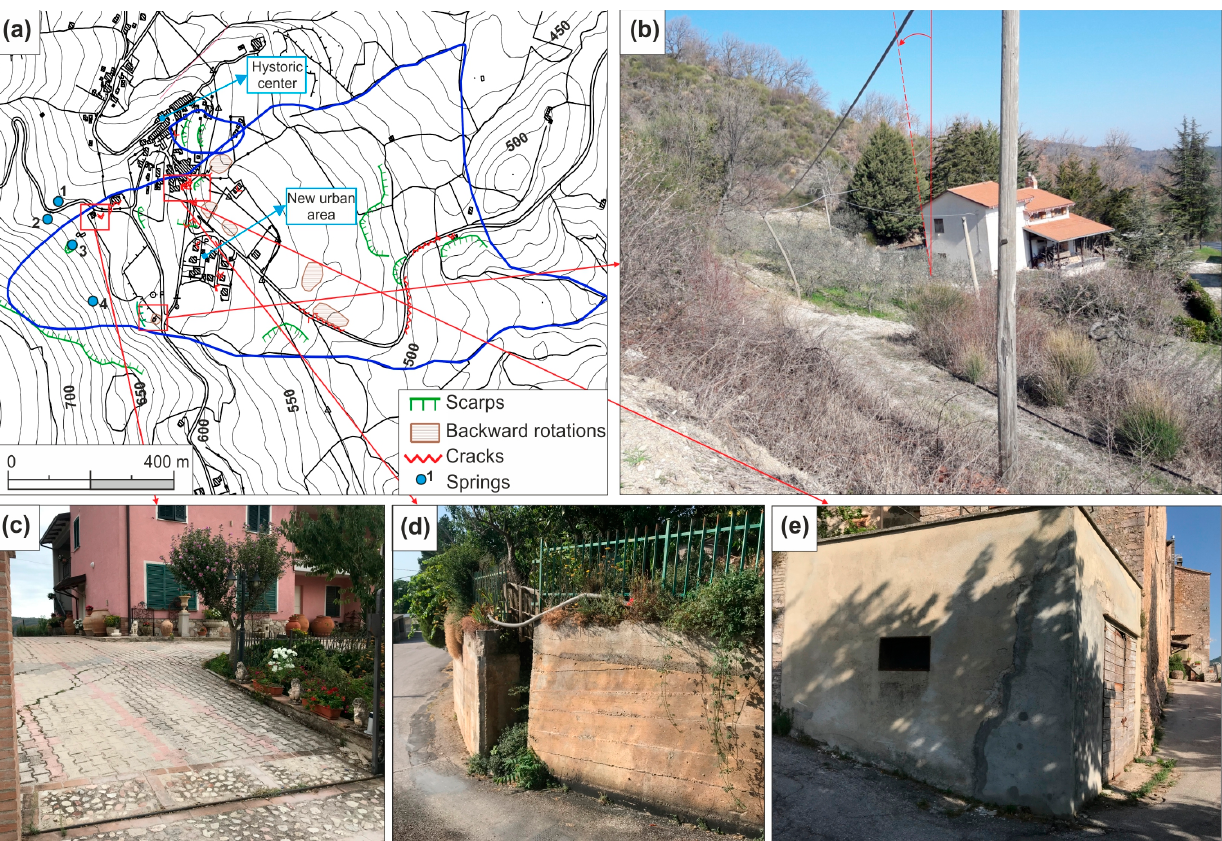
Figure 2. ( a ) Main geomorphological features obtained by the field survey with some examples of effects produced by the landslide on some structures; ( b ) Backward rotation of a sparse house; ( c ) Cracks in the floor pertaining to a dwelling; ( d ) Opening of a retaining wall; ( e ) Cracking on a building wall.